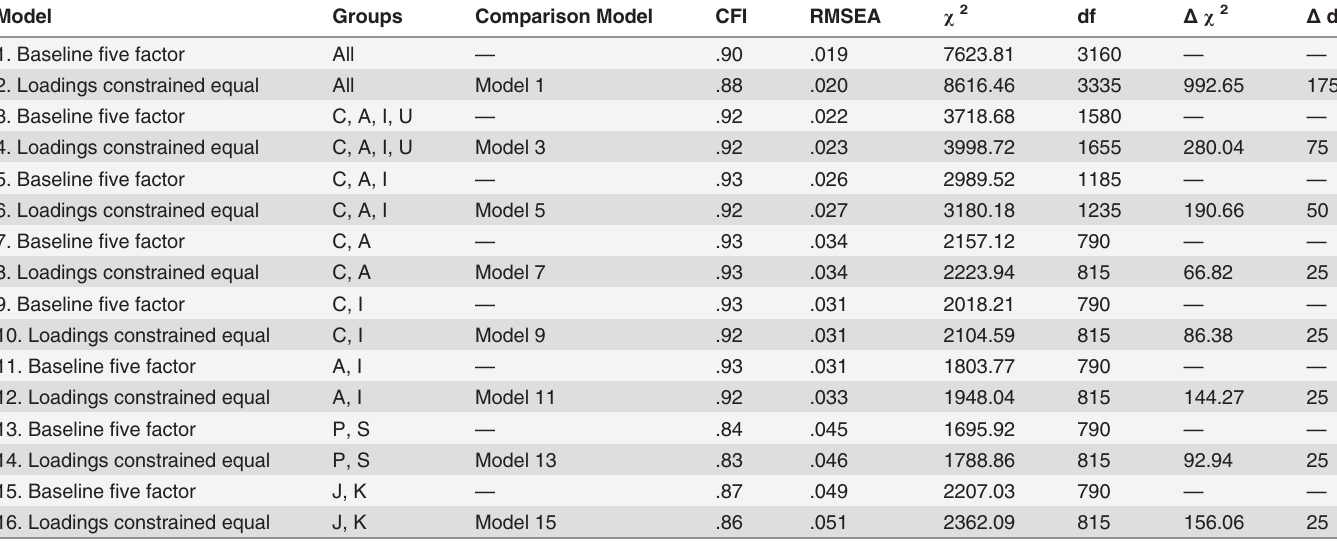
Table 16. Tests of Measurement Invariance for the ESI-R.